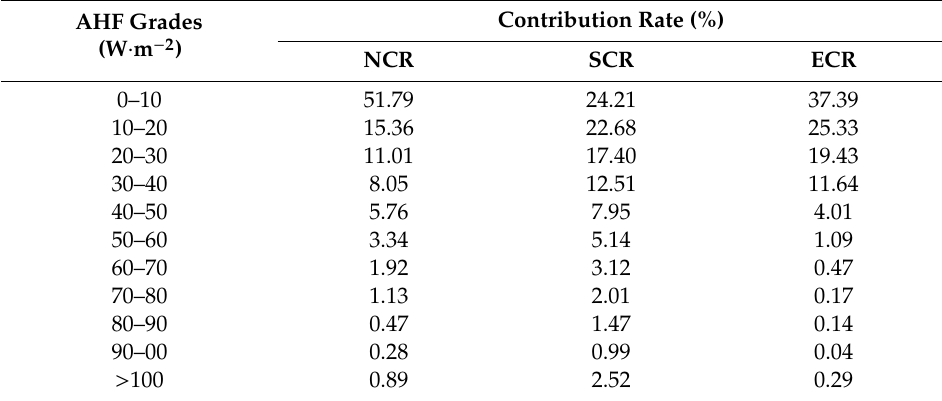
Table 3. AHF contribution rates of di ff erent grades in sub-regions.